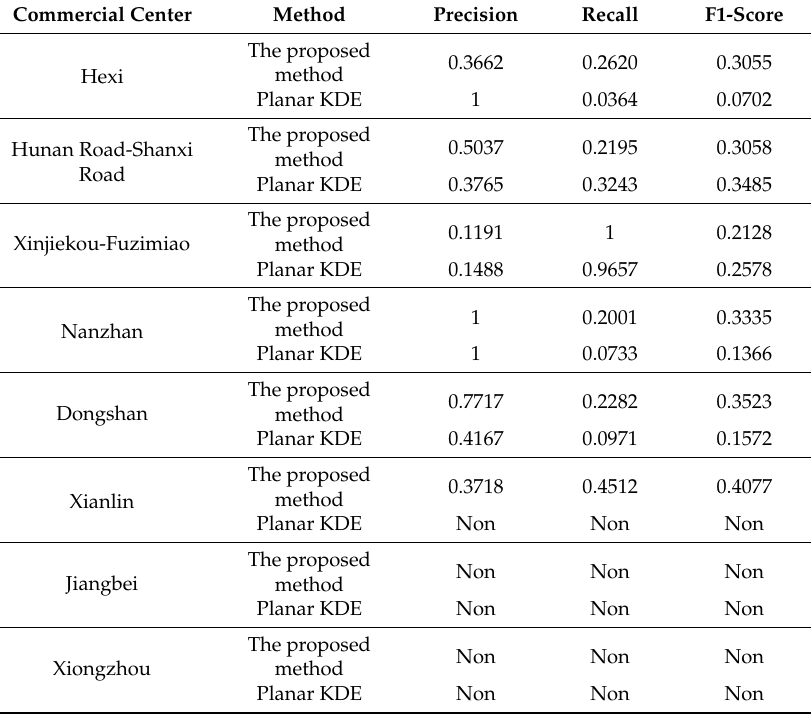
Table 7. Accuracy comparison of the extraction results with 300-m